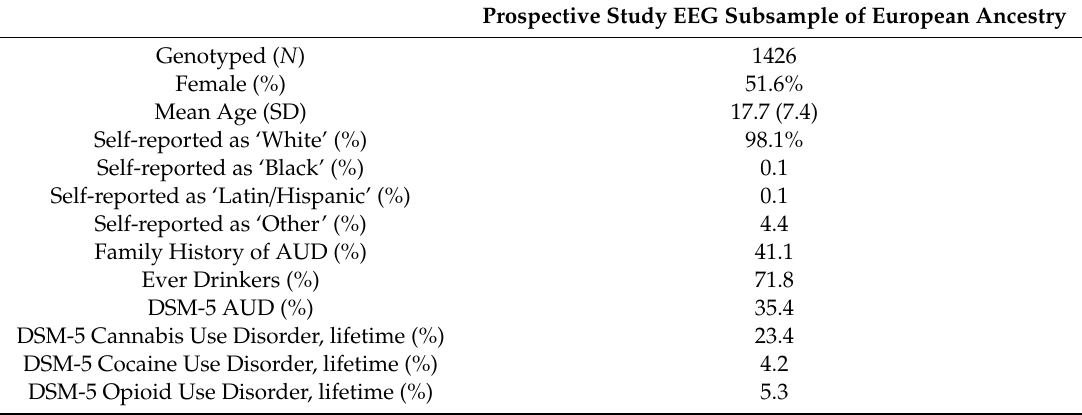
Table 1. Descriptive characteristics in the analytic